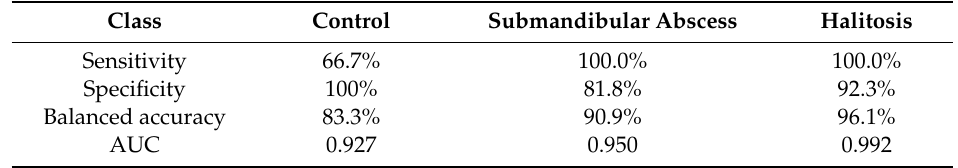
Table 2. Sensitivity, specificity, balanced accuracy, and AUC (area under the curve) obtained from Random Forest-based model for classification of studied clinical